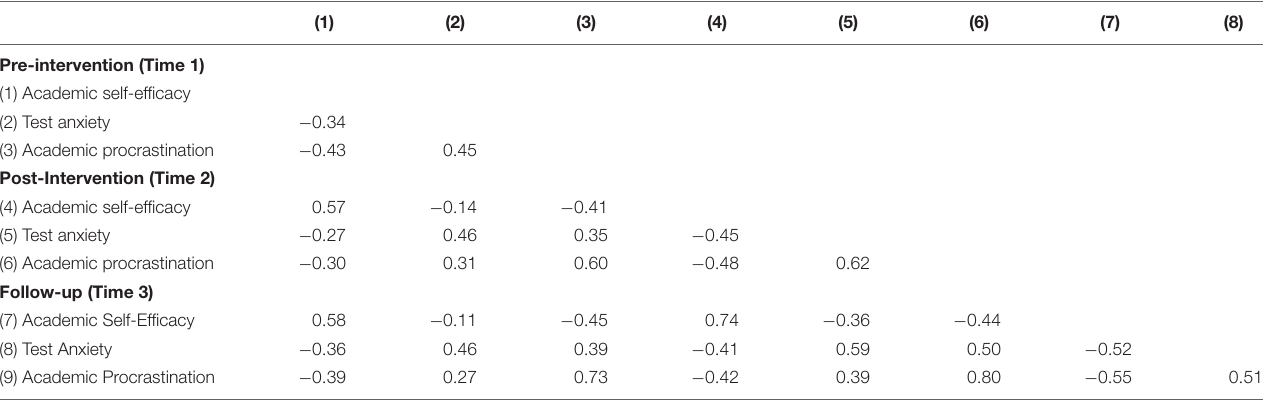
TABLE 2 | Zero-order correlations of dependent variables.